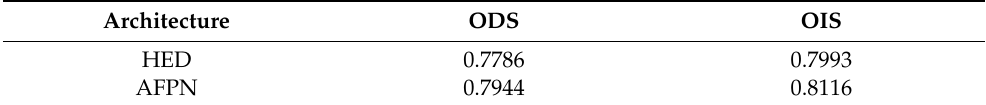
Table 3. Effect of the network structure.